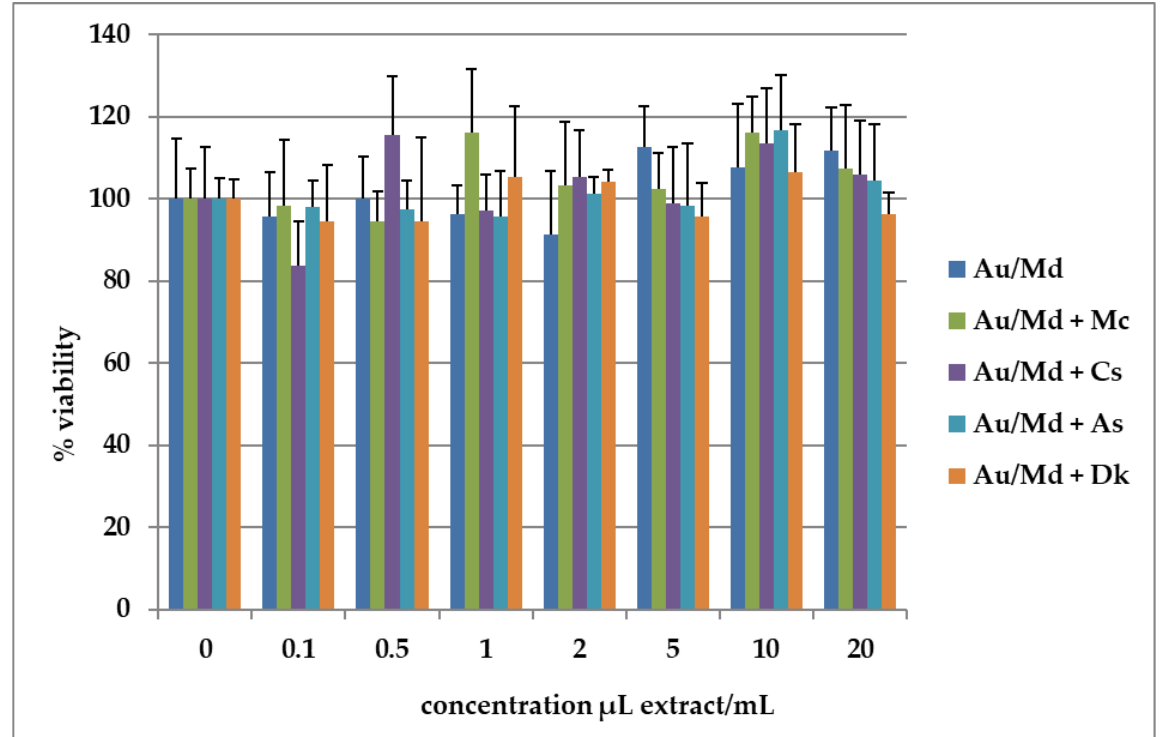
Figure 1. Cell viability of the best five extracts of strawberry tree fruit/apple smoothies. Results expressed as % of the control samples, measured in Caco-2 cells after incubation with different con- centrations of the extracts of the five selected fresh final products or equivalent volume MeOH:H 2 O 80:20 for the controls, and incubated for 24 h. Values were shown as mean ± SD ( n = 6 per group).